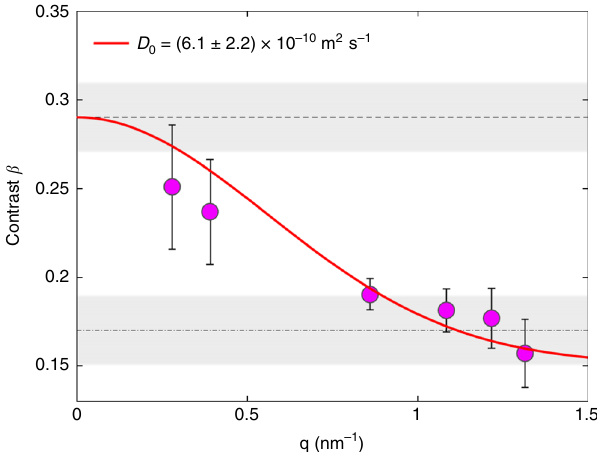
Fig. 4 Speckle contrast revealing nanosecond dynamics. q dependent contrast decay caused by diffusing gold nanoparticles and measured via the split-pulse XPCS method with two X-ray pulses separated by 1.3 ns. The red line corresponds to the model described in the text and yields the free particle diffusion coef fi cient D 0 . The horizontal gray bands refer to the expected limiting contrast values for a splitting ratio of 1.66 ( F LB = 0.625). The center of each band is denoted by a horizontal line. The error of data points was calculated based on Supplementary Eq. (3) (see Supplementary Note